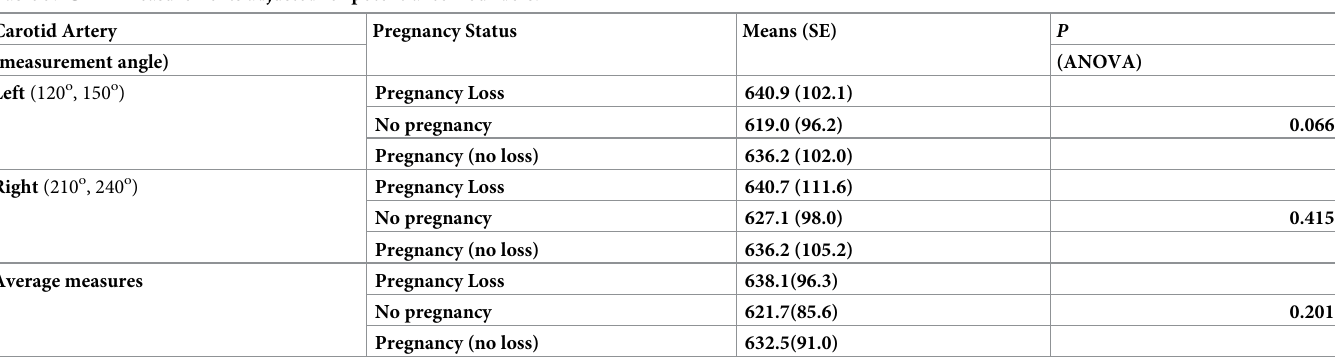
Table 5. CIMT measurements adjusted for potential confounders. Carotid